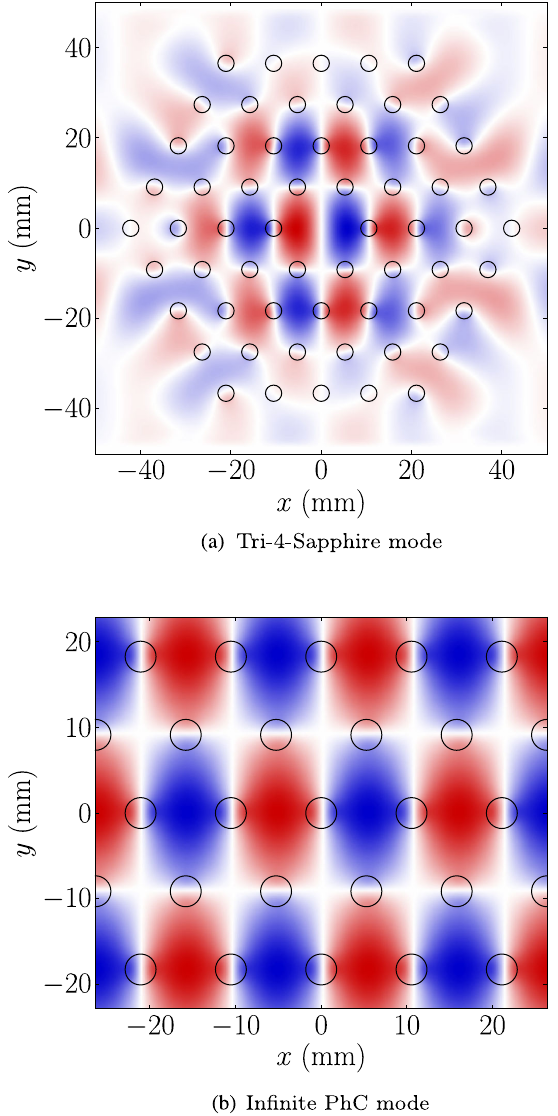
FIG. 10. Analagous modes in (a) the Tri-4-Sapphire periodic single-cell cavity and (b) an infinite 2D PhC [the mode pattern in (b) is uniform in z ]. The propagating PhC mode in (b) has a vanishing group velocity; thus, its counterpart in (a) is “ trapped ” and contributes significantly to the dipole wakefield. Computa- g tions used (a) VORPAL [31] and (b) MIT Photonic Bands